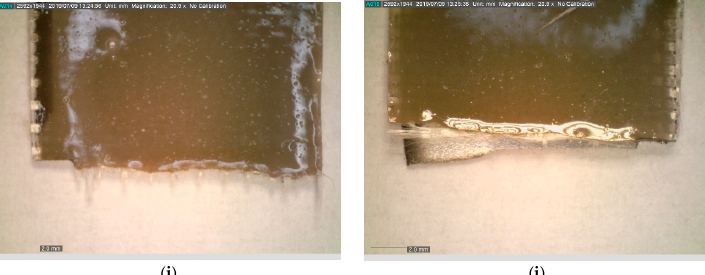
Figure 10. Images of the fracture area after fatigue test for samples: ( a , b ) EP; ( c , d ) EP_GF; ( e , f ) Figure10. Imagesofthefractureareaafterfatiguetestforsamples: ( a , b )EP;( c , d )EP_GF;( e , f EP_GF_HF; ( g , h ) EP_PUA; ( i , j ) EP_GF_PUA. Coatings with glass fiber as a constituent had a visible asymmetric fracture surface. In case of all samples, there was visible delamination of the coating from the metallic base. The area of